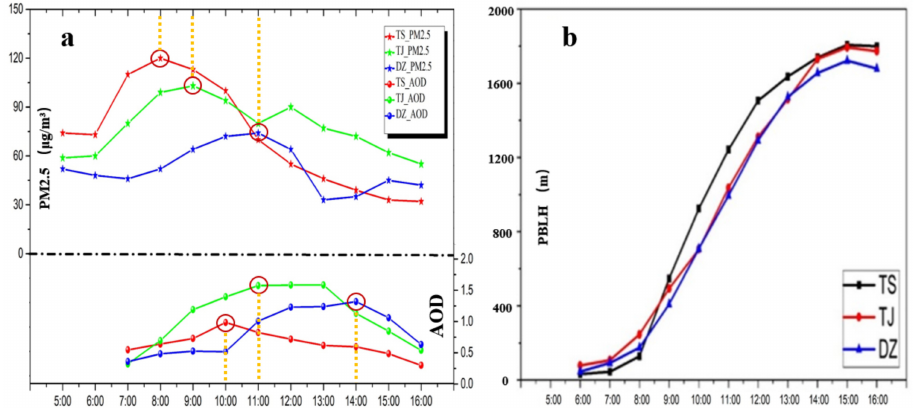
Figure 8. ( a ) Changes in fine particulate matter concentration and AOD during polluted period; ( b ) changes in planetary boundary layer height during polluted